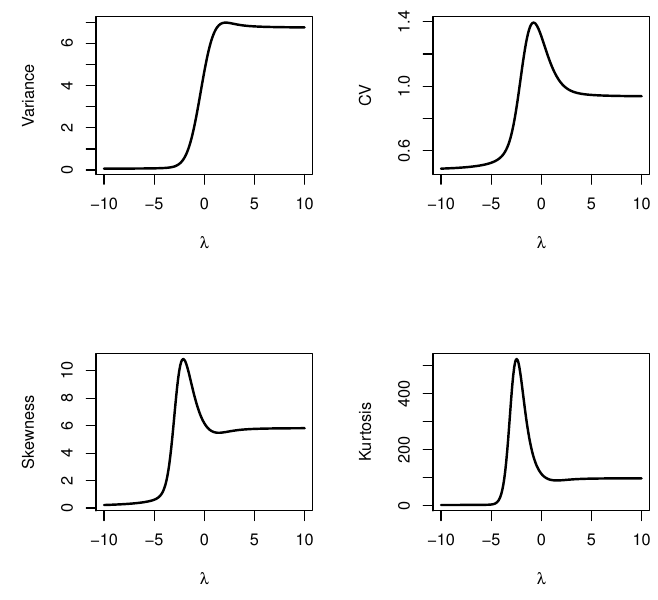
Figure 4. Plots of the variance, CV, skewness, and